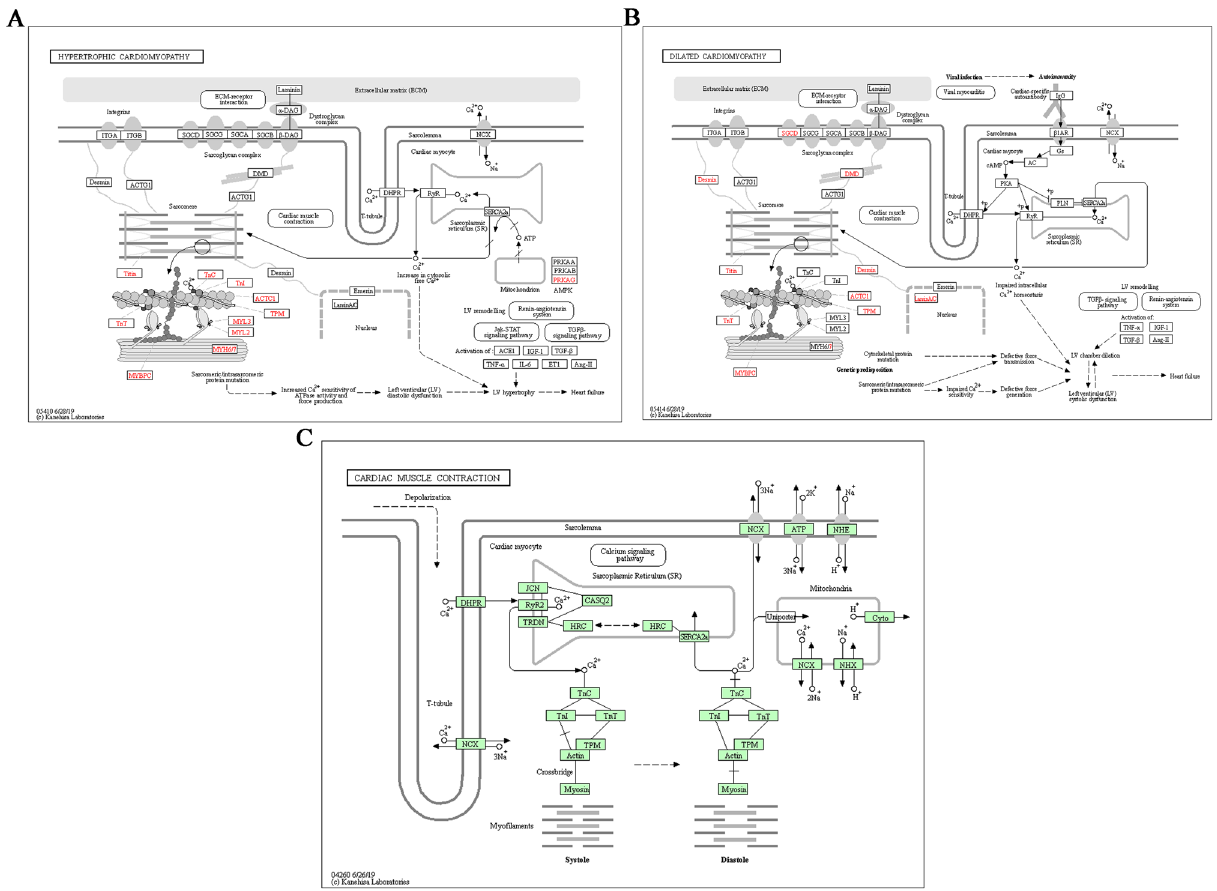
Figure 6. Signaling pathways of hypertrophic cardiomyopathy, dilated cardiomyopathy and cardiac muscle contraction. Diagrams created by Kanehisa Laboratories and used with